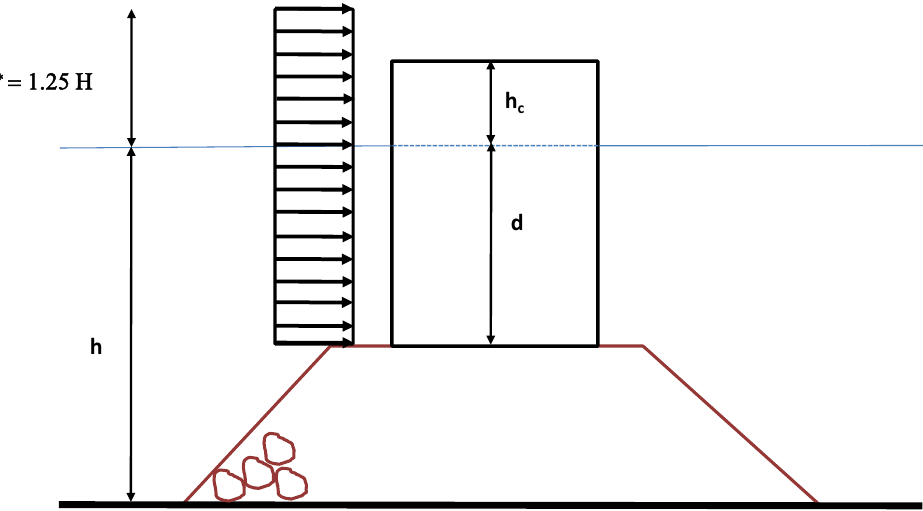
Figure 6. Definition sketch for the Hiroi